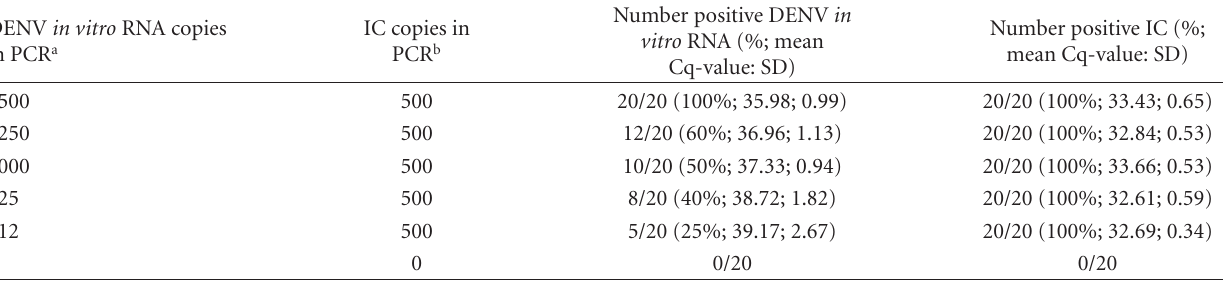
Table 4: LOD of the generic real-time PCR a